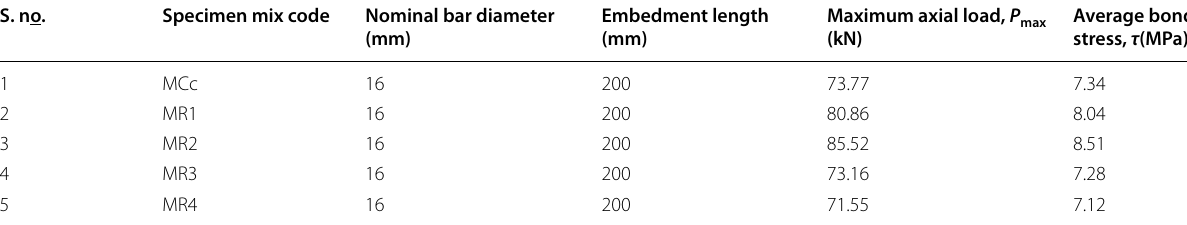
Table 6 Average bond stress of HSC